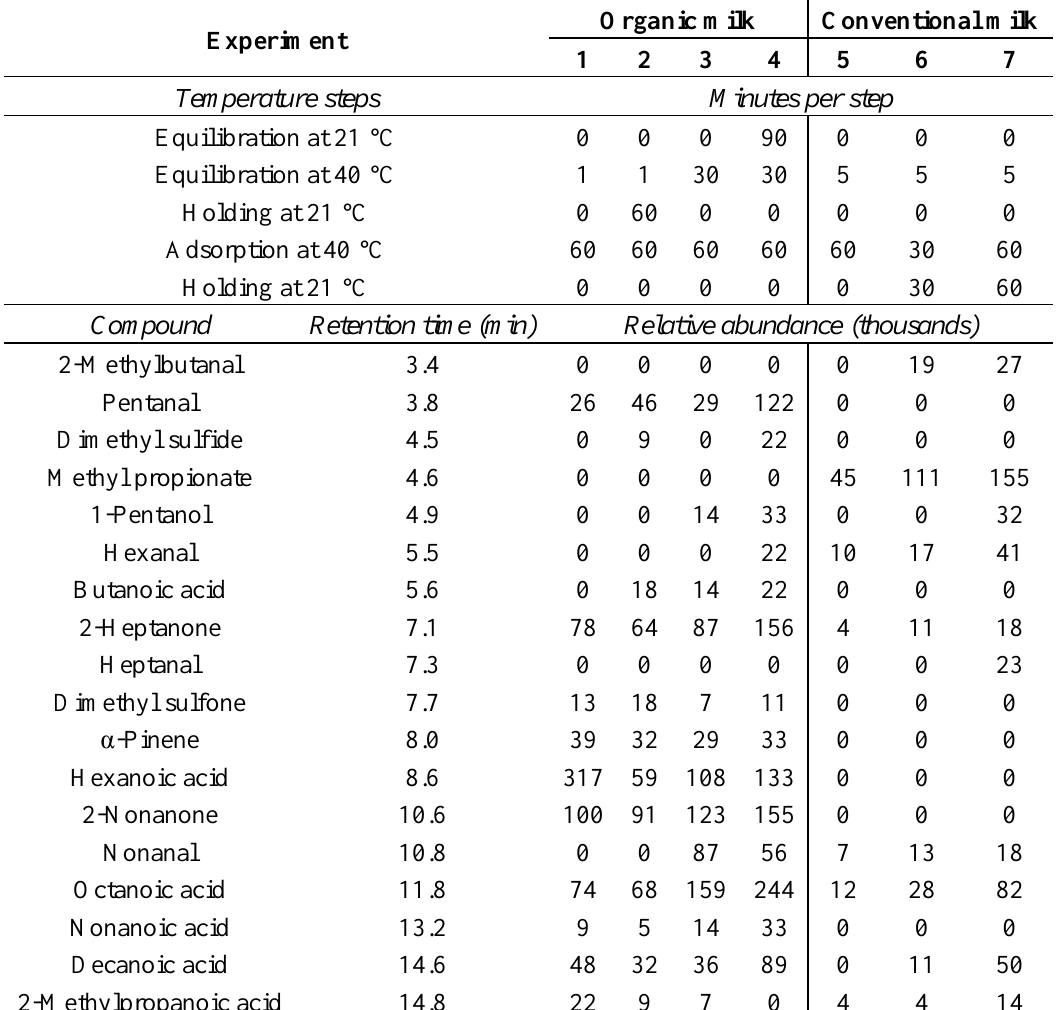
Table 2. Relative abundance of volatile compounds in milk, and variations with temperature